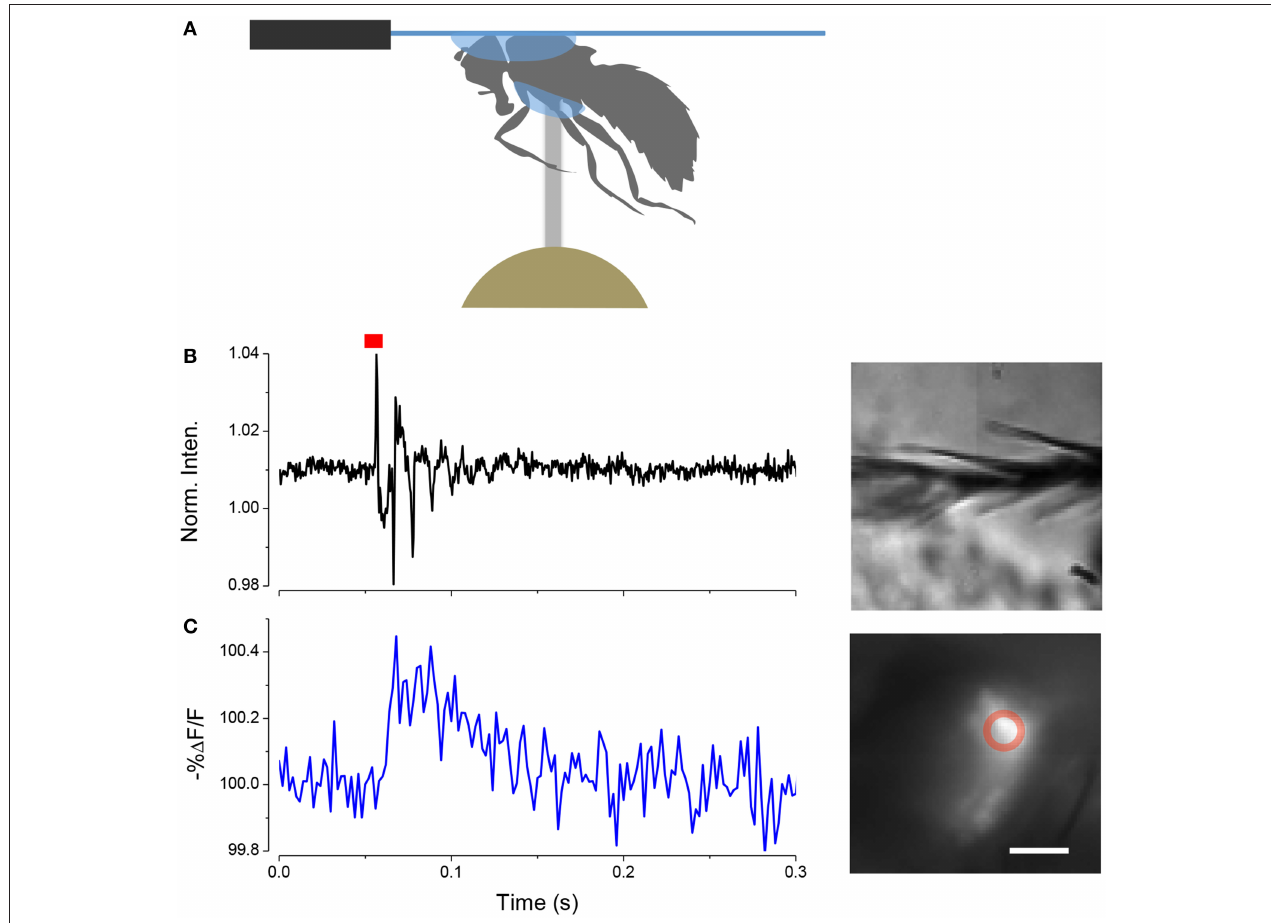
FIGURE 8 | Mounting live flies with LCR. (A) Schematic of the mounting procedure. (B) Movement of arista (inset right) induced by a single sound pulse (red). (C) Response of JO expressing ArcLight in the same fly as (B) . Scale bar 20 µ